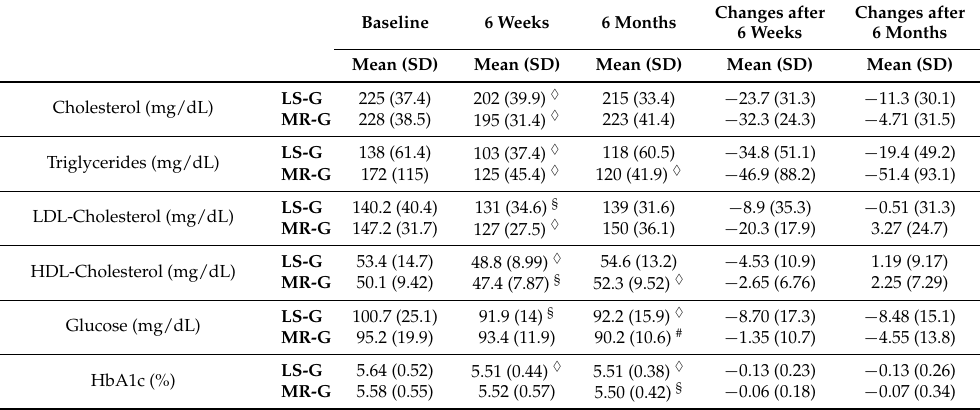
Table 2. Total cholesterol, triglycerides, LDL- and HDL-cholesterol, glucose and HbA1c levels during the course of the study. Mean ˘ standard deviation (SD). LS-G, lifestyle intervention group;